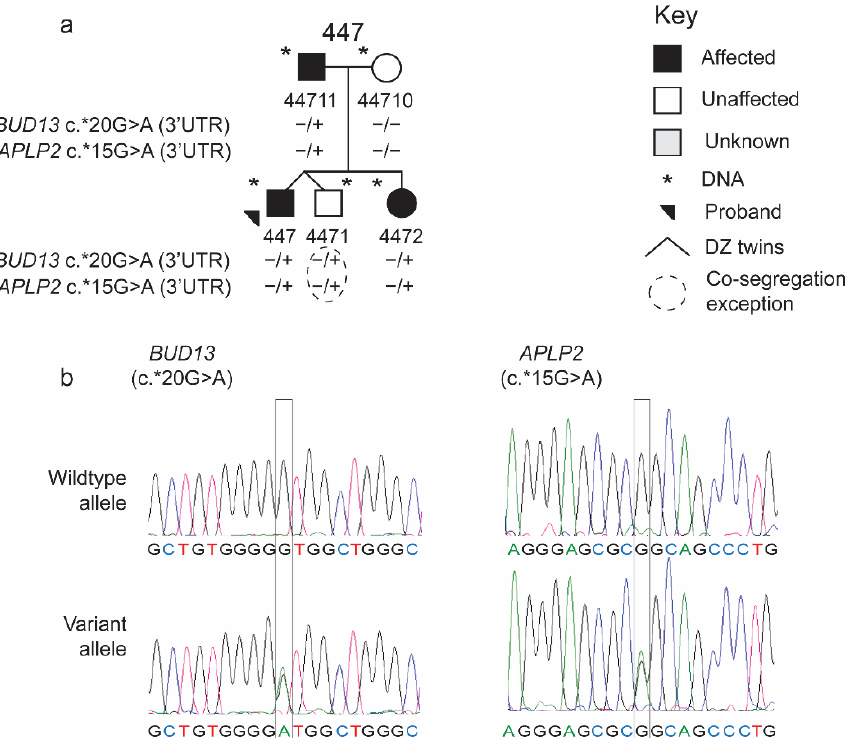
Figure 2. APLP2 and BUD13 3 ′ UTR variants co-segregating in family 447. ( a ) The family 447 pedigree and co-segregation of the two identified variants. ( b ) Electropherograms showing the variant and wildtype alleles for the two identified variants.